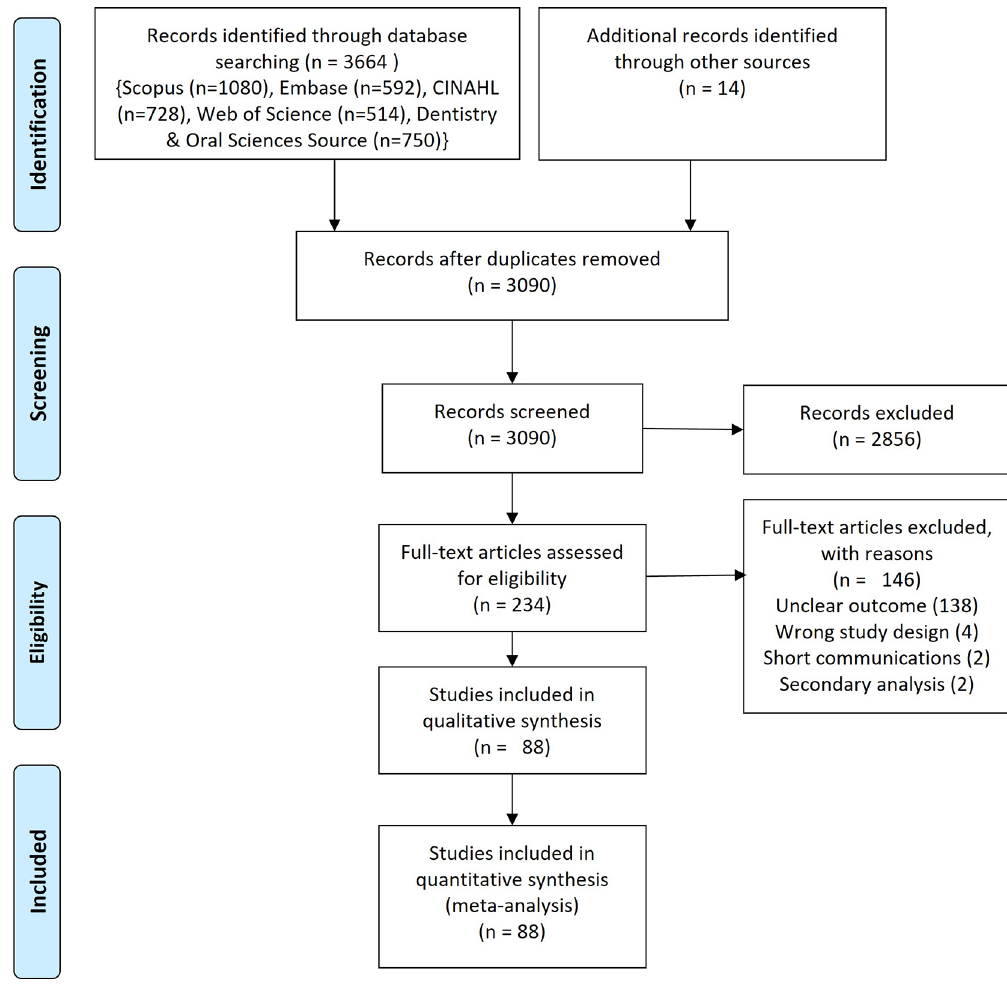
Figure 1. PRISMA flow chart.